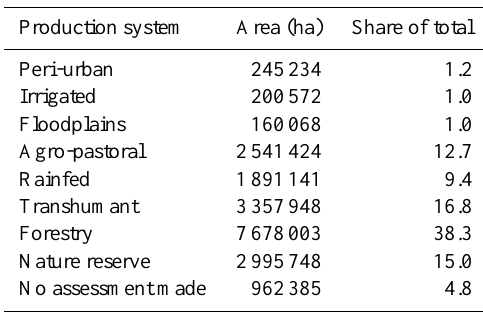
Table 2. Production system, area (in hectare), and share of total land area in